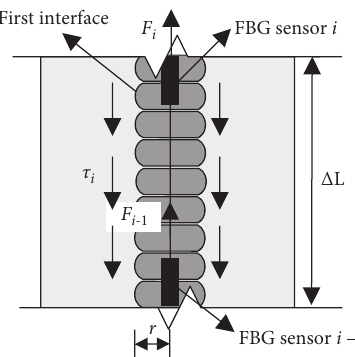
Figure 4: Stress condition between two adjacent FBG